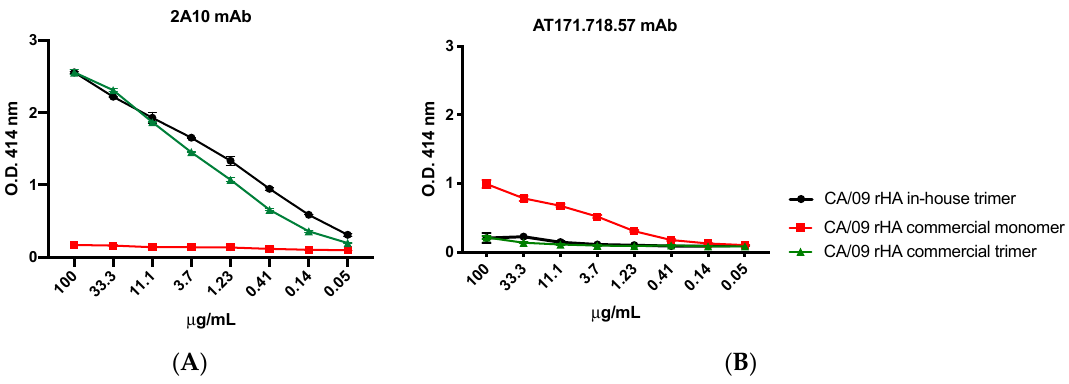
Figure 9. Binding activity of: murine mAbs specific for the HA trimer (clone 2A10) ( A ); and the HA